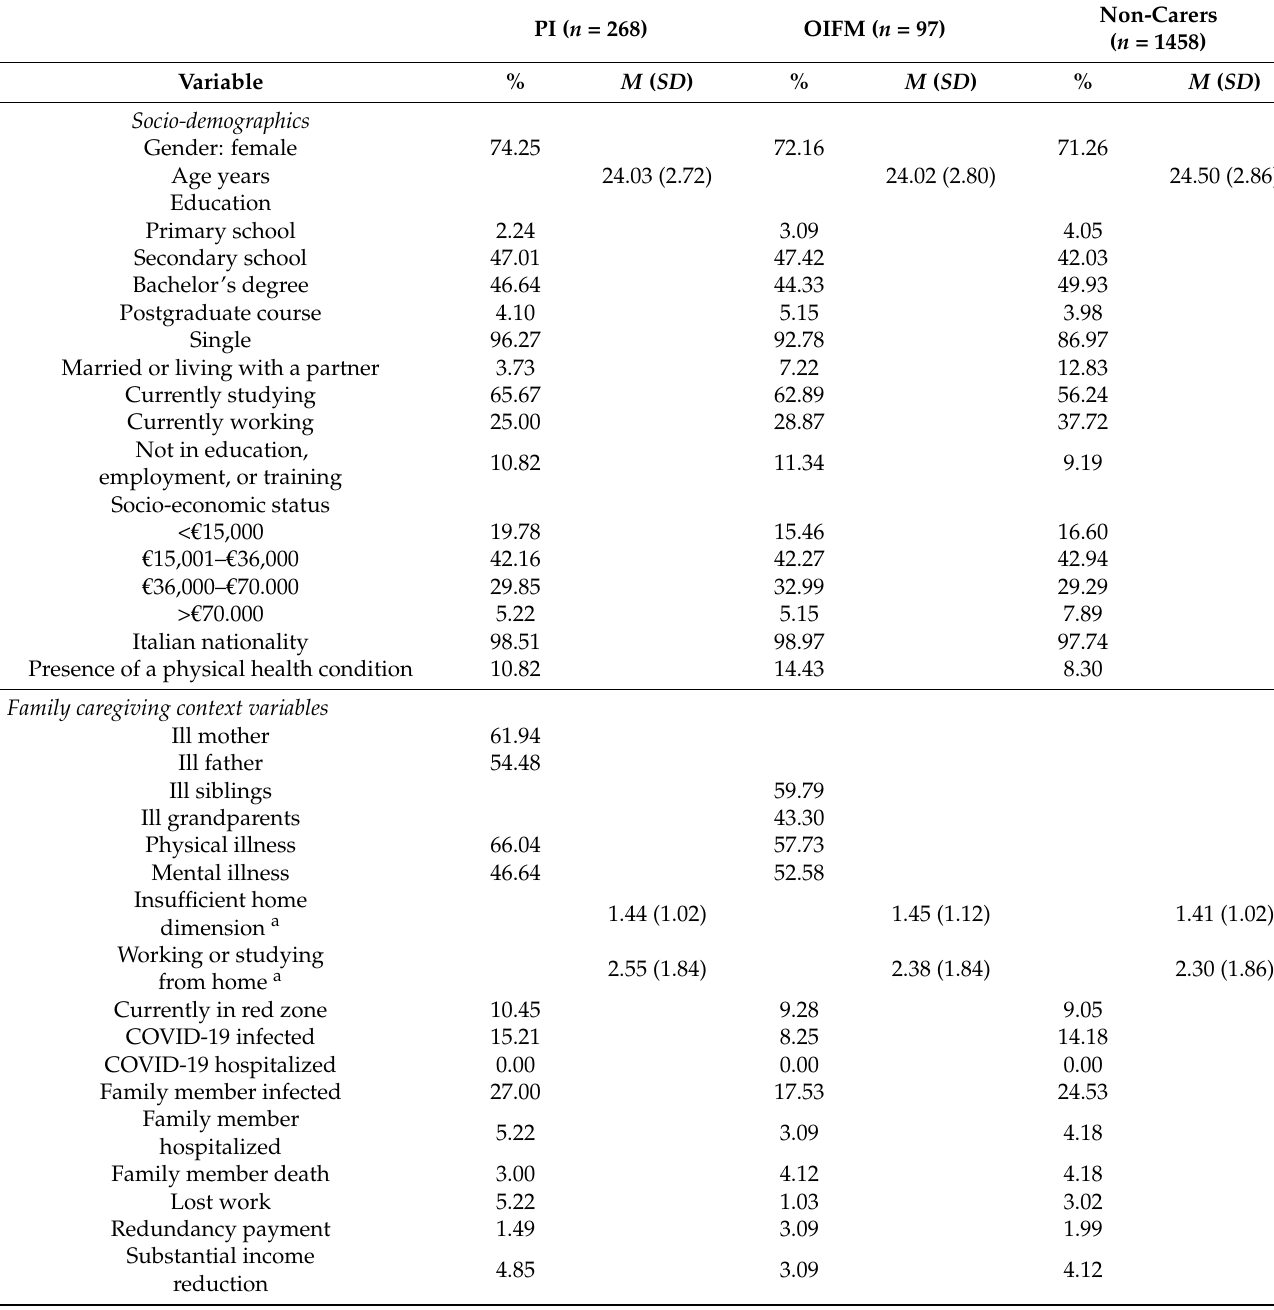
Table 1. Descriptive data on socio-demographics, caregiving context and COVID-19 context variables in the parental illness group (PI), other ill family member (OIFM) group, and non-carer